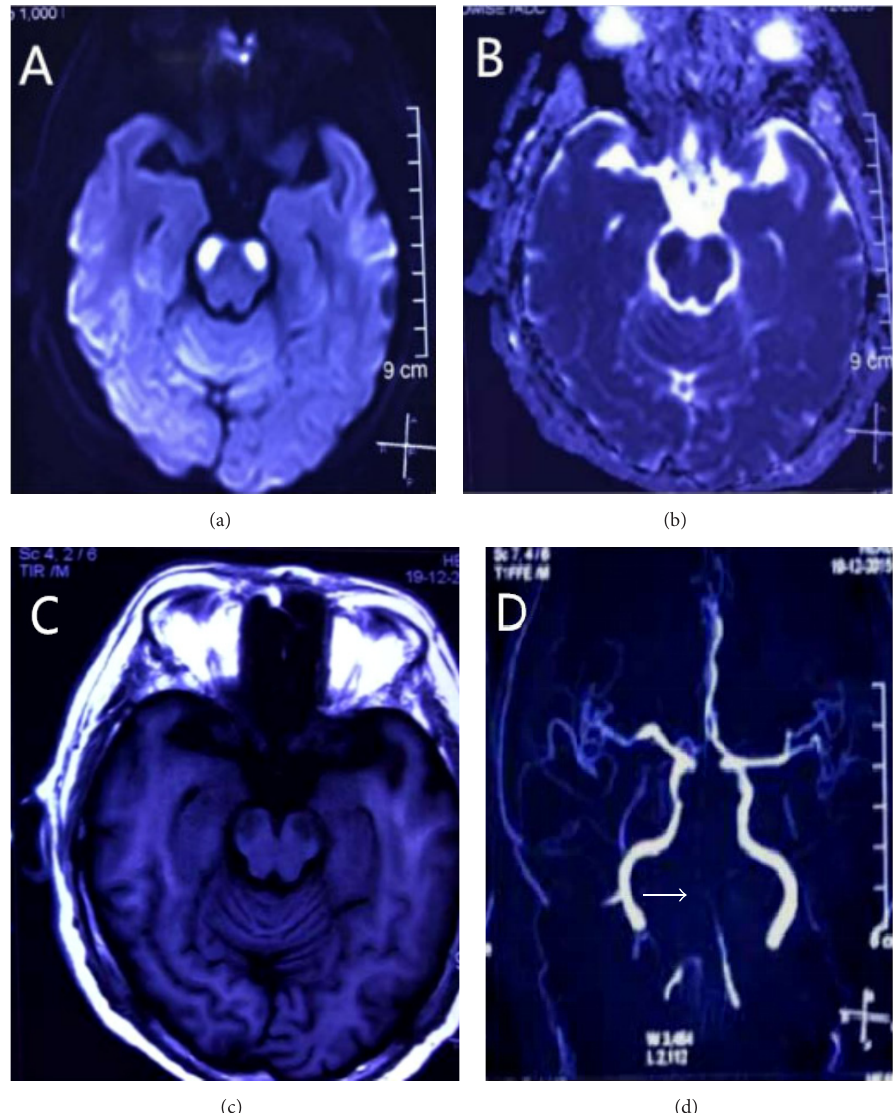
Figure 1: (a) Diffusion-weighted image showing high signal intensity in bilateral cerebral peduncles, with corresponding hypointensity on apparent diffusion coefficient map (b). T1-weighted (c) magnetic resonance imaging showing low intensity in bilateral cerebral peduncles with sparing of the medial and most of the lateral portion with low signal intensity. The entire basilar and distal vertebral arteries (white arrow) are not shown on the magnetic resonance angiography (MRA)